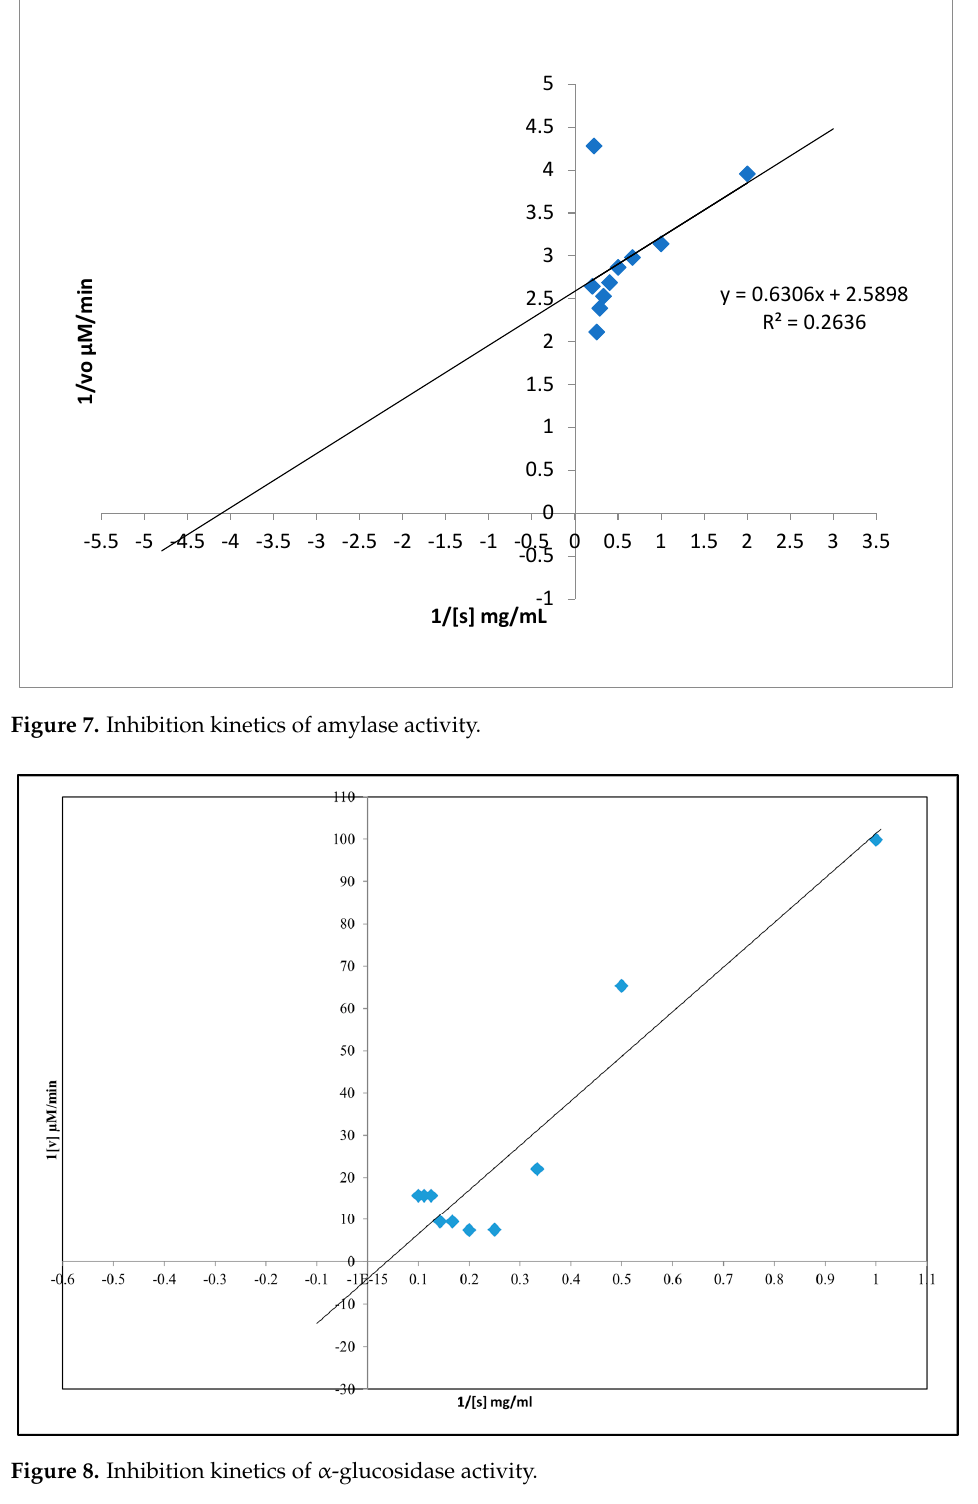
Figure 9. Inhibition kinetics of urease activity. 4. Conclusions In the present investigation, the extraction of the phytocompounds of A. concinna and C. limon was performed. The plant extracts showed significant antimicrobial activities against studied pathogenic bacteria owing to the presence of phytocompounds such as alkaloids, flavonoids, and phenols. The inhibition of α -amylase, α -glucosidase, and urease enzymes showed that the plants could be used in the management of diabetes and acid- peptic disorders. Silver nanoparticles synthesized using A. concinna extract exhibited an- timicrobial activities against pathogenic Z. mobilis . The current study demonstrates that the bioactive chemicals found in A. concinna and C. limon can be used in clinical and phar- macological applications to treat a variety of ailments such as cancer, diabetes, gastroin- testinal ulcers, and bacterial infections. However, further research is warranted to eluci- date the exact mechanism of action of these medicinal plants.